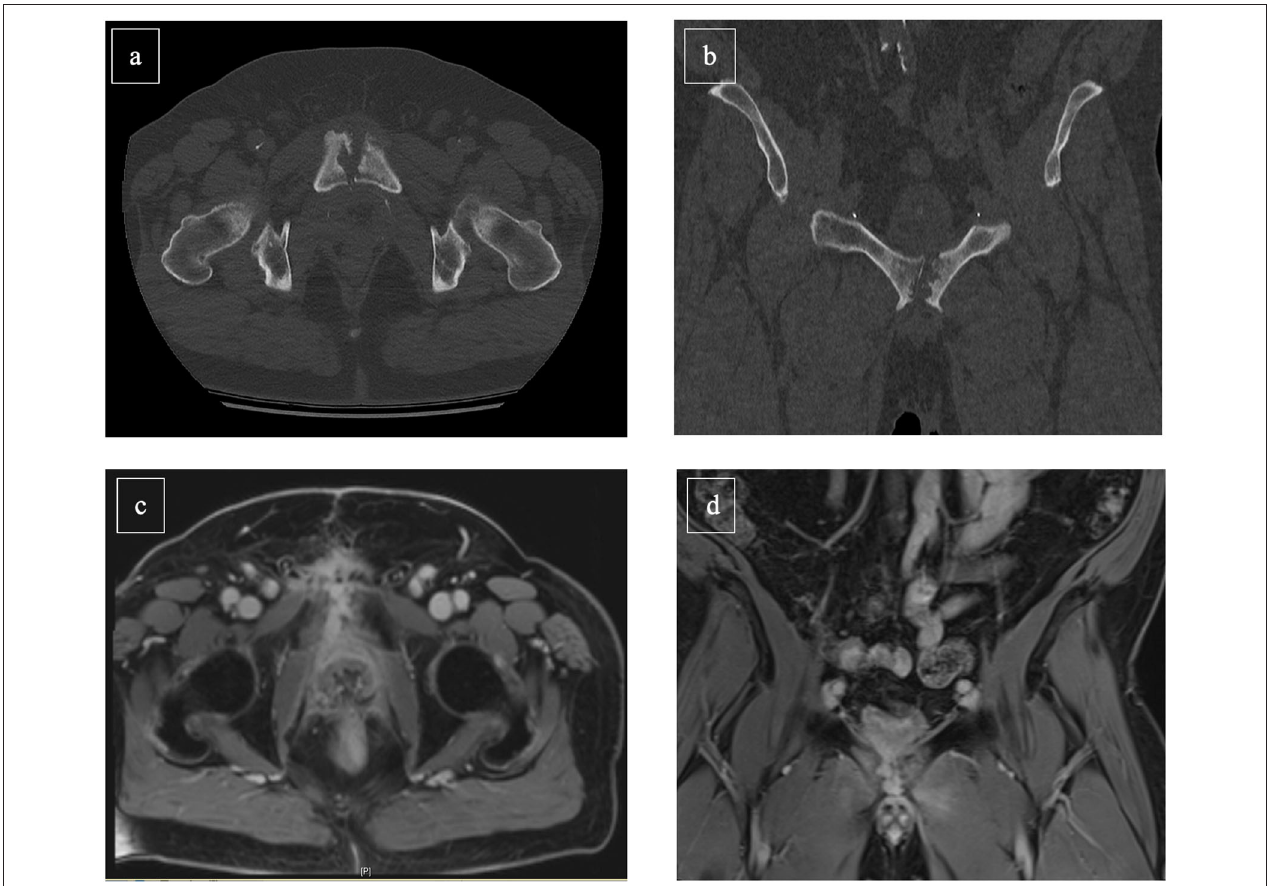
FIGURE 1 | Abdominal CT scan [ (a) : transversal, (b) : frontal] and MR-Imaging [ (c) : transversal, (d) : frontal] of a 56-year-old prostate cancer patient suffering osteomyelitis following photon-beam radiation therapy of the prostate (2017) and salvage radical prostatectomy with persistent insufficient anastomosis (2019). Cystectomy with Mainz-I pouch with appendix-nipple was successful performed. Furthermore, symphyseal resection and omentus major flap was simultaneously